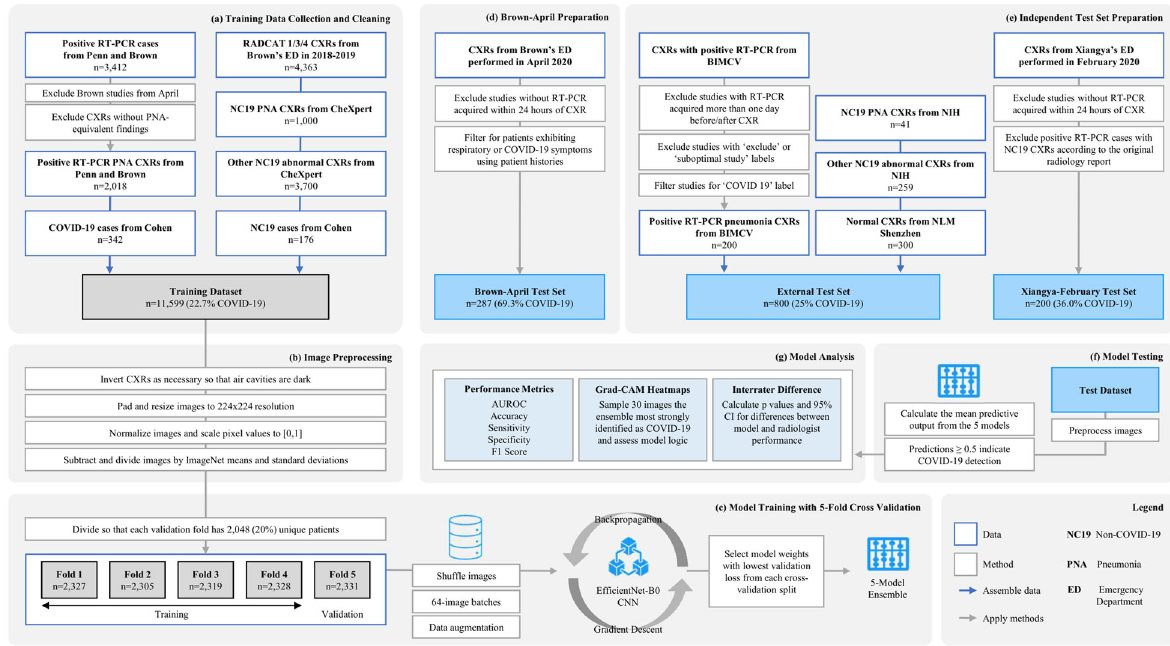
Fig. 5 COVID-19 diagnosis prediction model development. The fl owchart delineates the inclusion and exclusion criteria for the training and testing cohorts, as well as the methods to train, test, and evaluate the